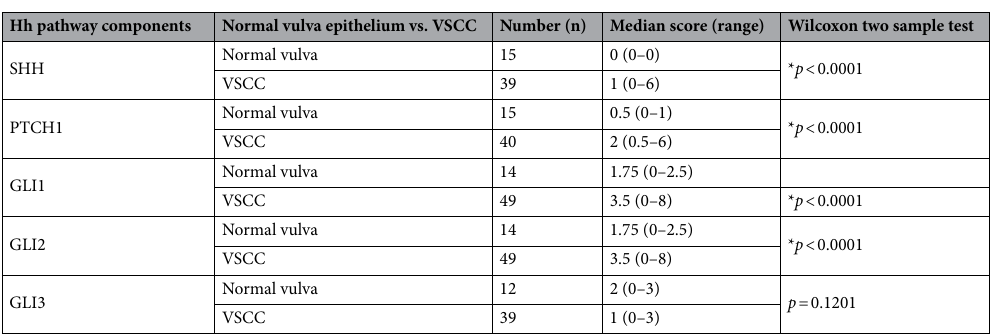
Table 1. Summary of Hedgehog pathway component expression in VSCC and age-matched normal vulval epithelium. * p < 0.05, Wilcoxon two sample test indicates that the difference in the Allred score was significant.